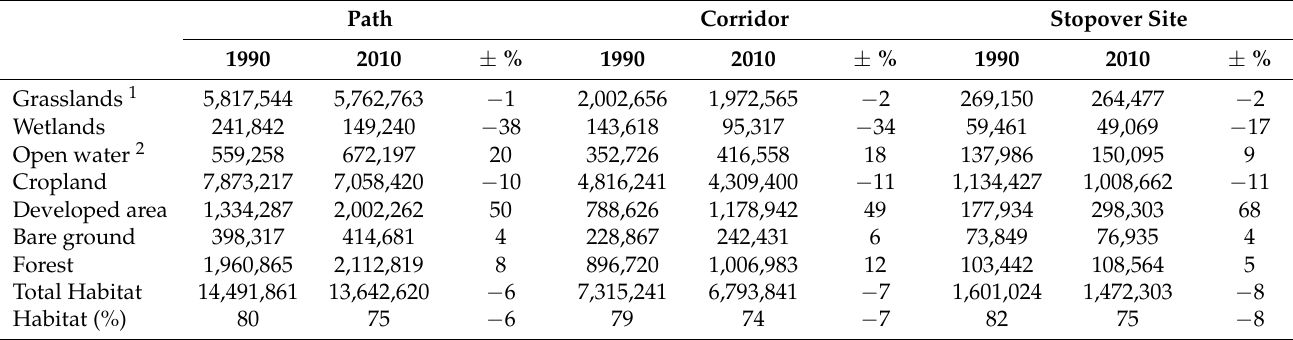
Table 5. Landcover (ha) within the current Duolun migratory path. Path Corridor Stopover Site